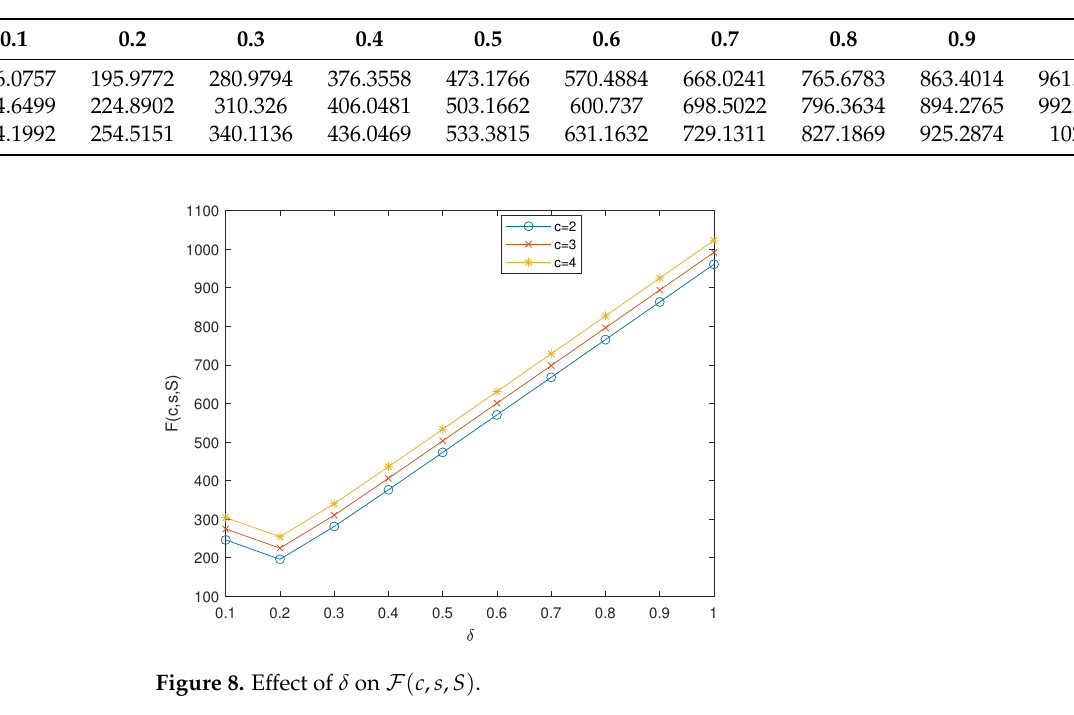
Table 10. Effect of δ on